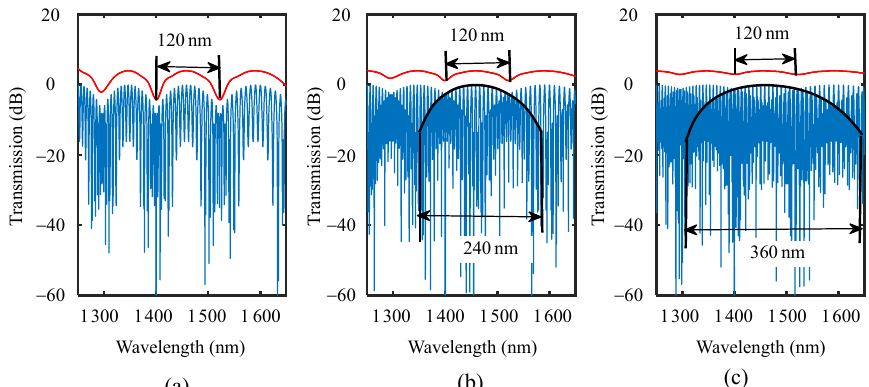
Fig. 3 Simulated transmission spectra of the PMF-SI with different harmonic order i : (a) fundamental Vernier, i =0, (b) first harmonic, i =1, and (c) to second harmonic, i =2. (Red line: the upper envelope of the interference spectrum; black line: part of the inner envelope of the interference spectrum).